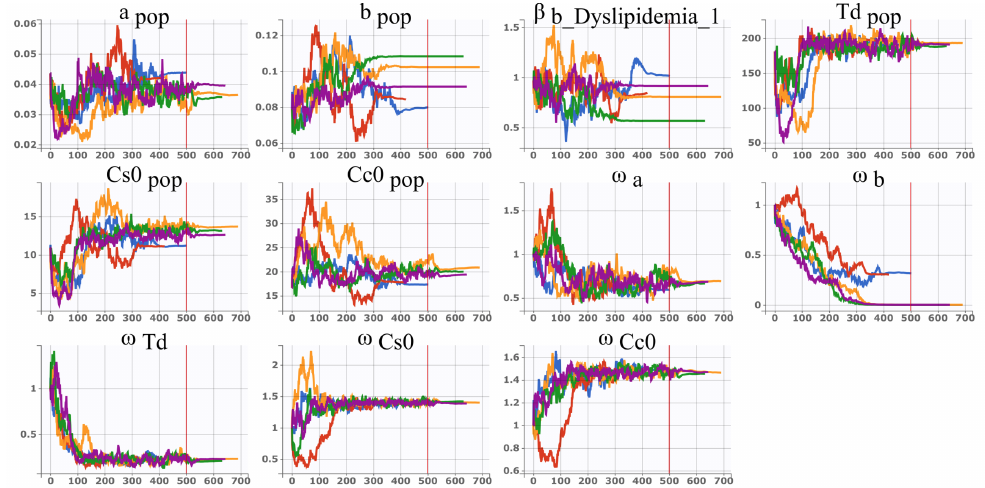
Figure 9. Population parameter estimates with respect to the iterations of SAEM during the conver- gence assessment of the model. Each color refers to a trajectory.